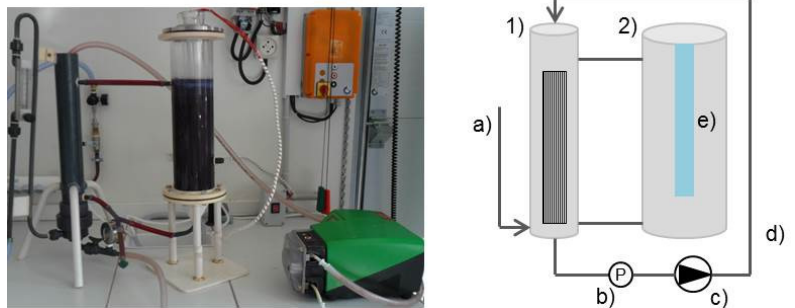
Figure 2. Photocatalytic membrane reactor: ( 1 ) membrane reactor; ( 2 ) photocatalytic reactor; ( a ) air inlet; ( b ) pressure measurement; ( c ) peristaltic pump; ( d ) permeate; and ( e ) UV lamp.